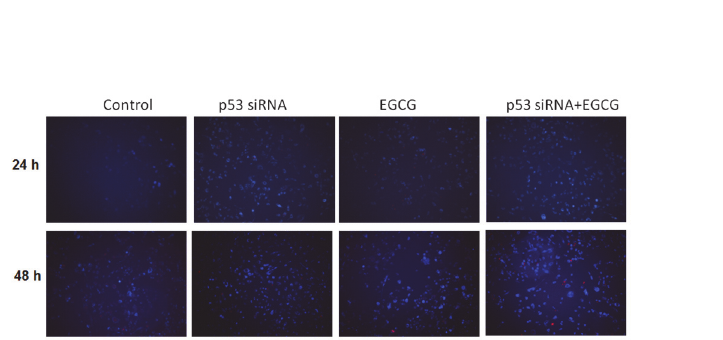
Fig 3. Cell network formation. Microscopical evaluation was done in the presence of the selected treatment scenarios at 24 and 48 h post-treatment in Hs578T cell line.